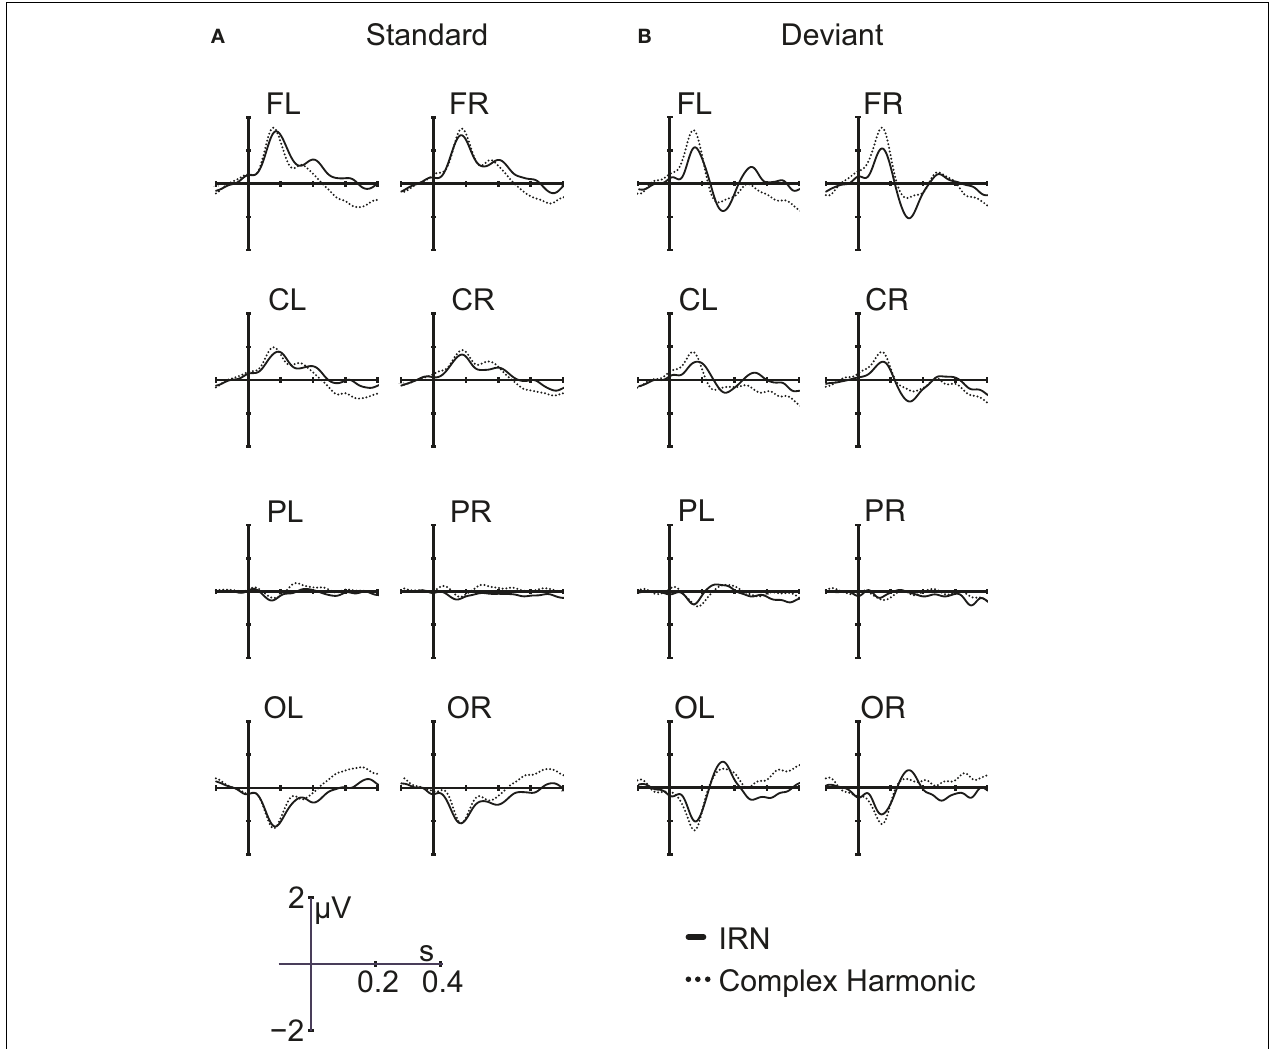
FIGURE 4 | Grand average waveforms in response to IRN and complex harmonic stimuli for standard trials (A) and deviant trials (B) for all eight scalp